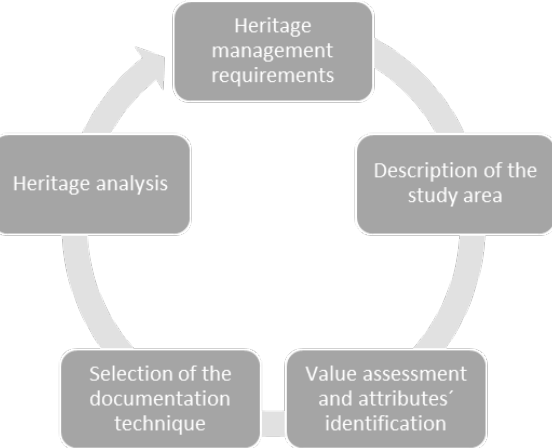
Figure 2. Heritage management process for the historic centre of Cuenca -